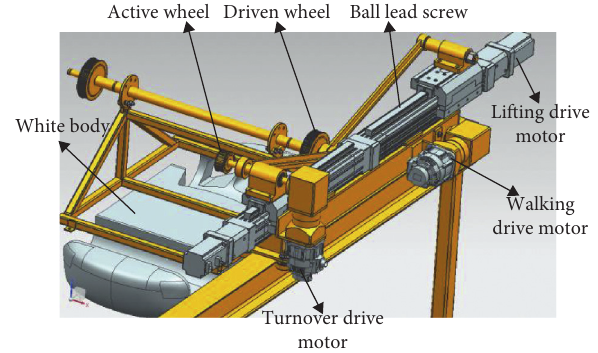
Figure 1: The mechanism schematics of